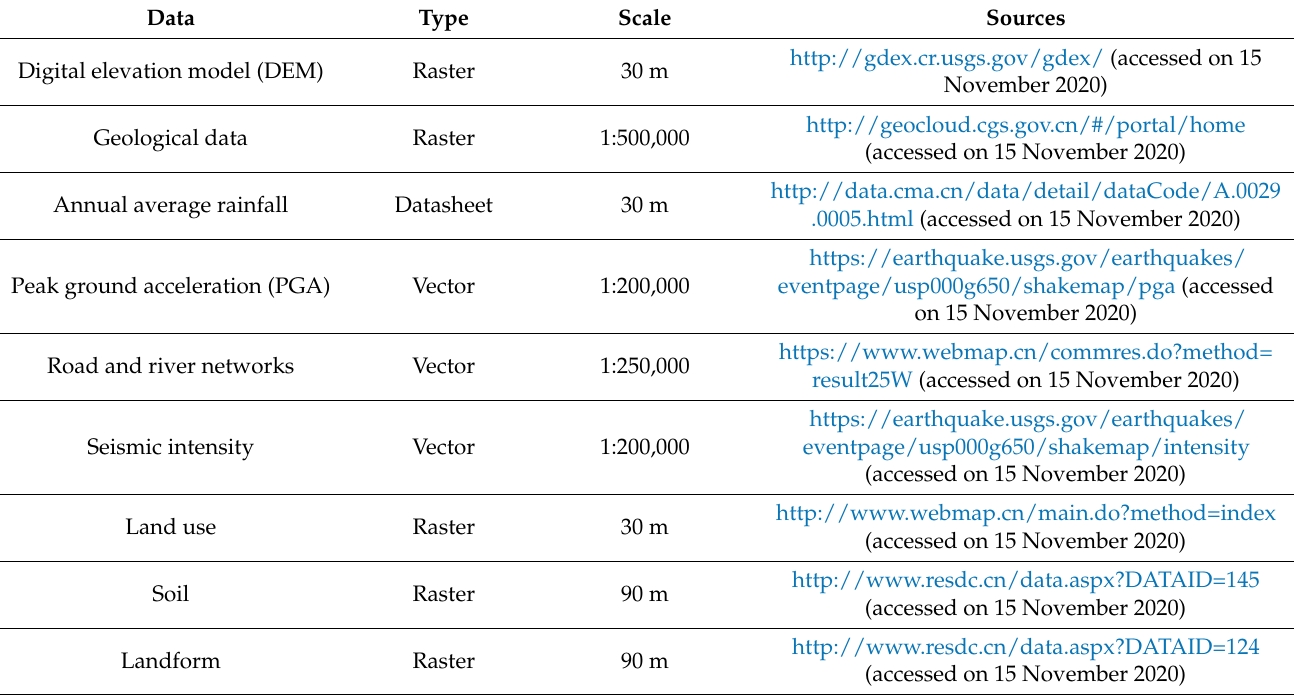
Table 1. Data sources used in this